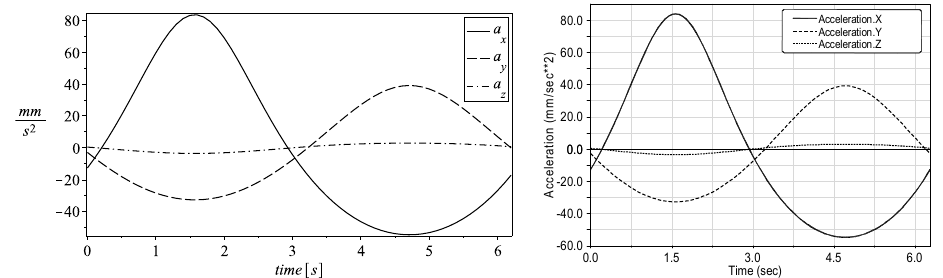
Figure 10. Acceleration of point P . Using screw theory ( left ); and simulations in ADAMS/View 2014 ( right ).